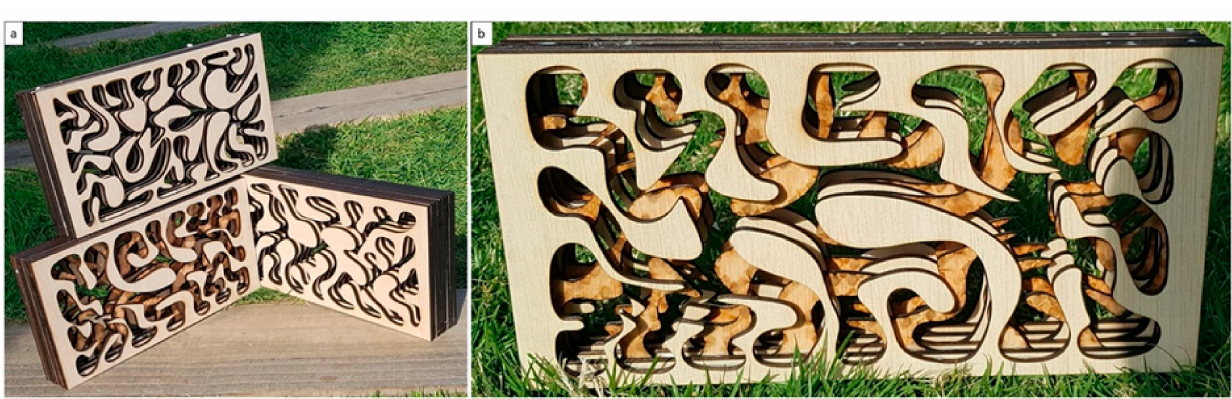
Figure 8. Alberto T. Est é vez (Yomna K. Abdallah, computational designer), Biodigital Barcelona Bricks, GENARQ/iBAG, UIC Barcelona. The three design iterations of the Biodigital Barcelona Bricks digitally fabricated in wood using a laser cutter. ( a ) The three different design iterations digitally cut in wood by a laser cutter, resulting in more design options and providing positive and negative profiles of the brick models per each design iteration. ( b ) Design iteration V1 was fabricated following the contouring strategy of the cut profiles of the brick in positive and negative profiles. ( c , d ) Design iteration V2 and V3 were fabricated by contouring the model in positive and negative profiles. Photos by the authors.